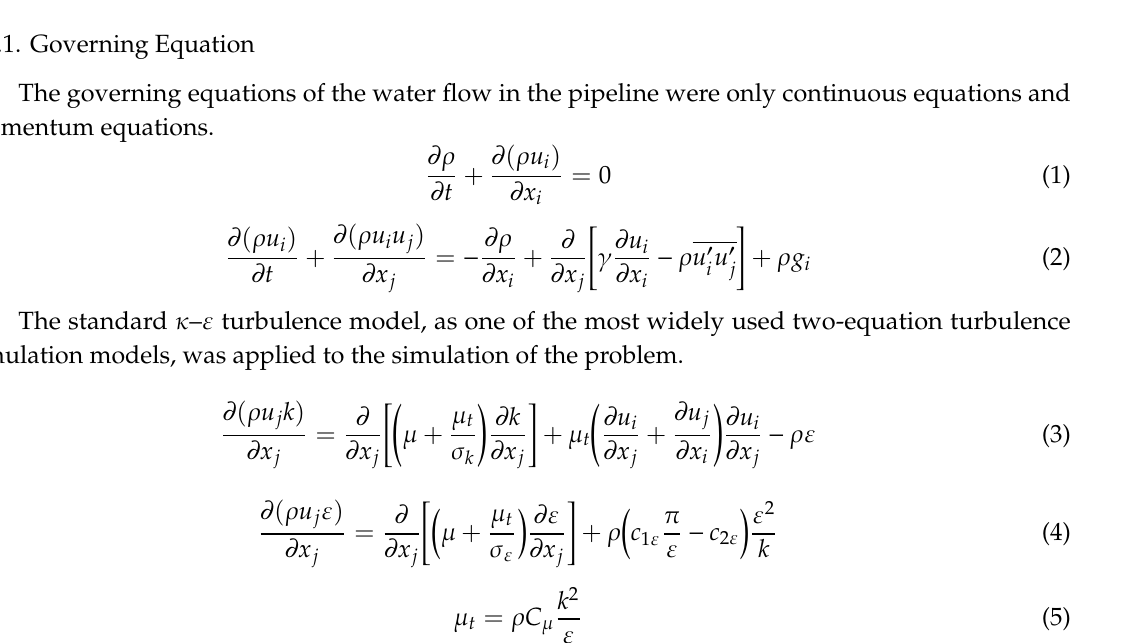
Table 1. Uncertainties of the experimental parameters. Parameter. Unit Uncertainty (%) Mass flow rate t/h 0.5 Pressure KPa 0.08 Fluid temperature °C 2.19